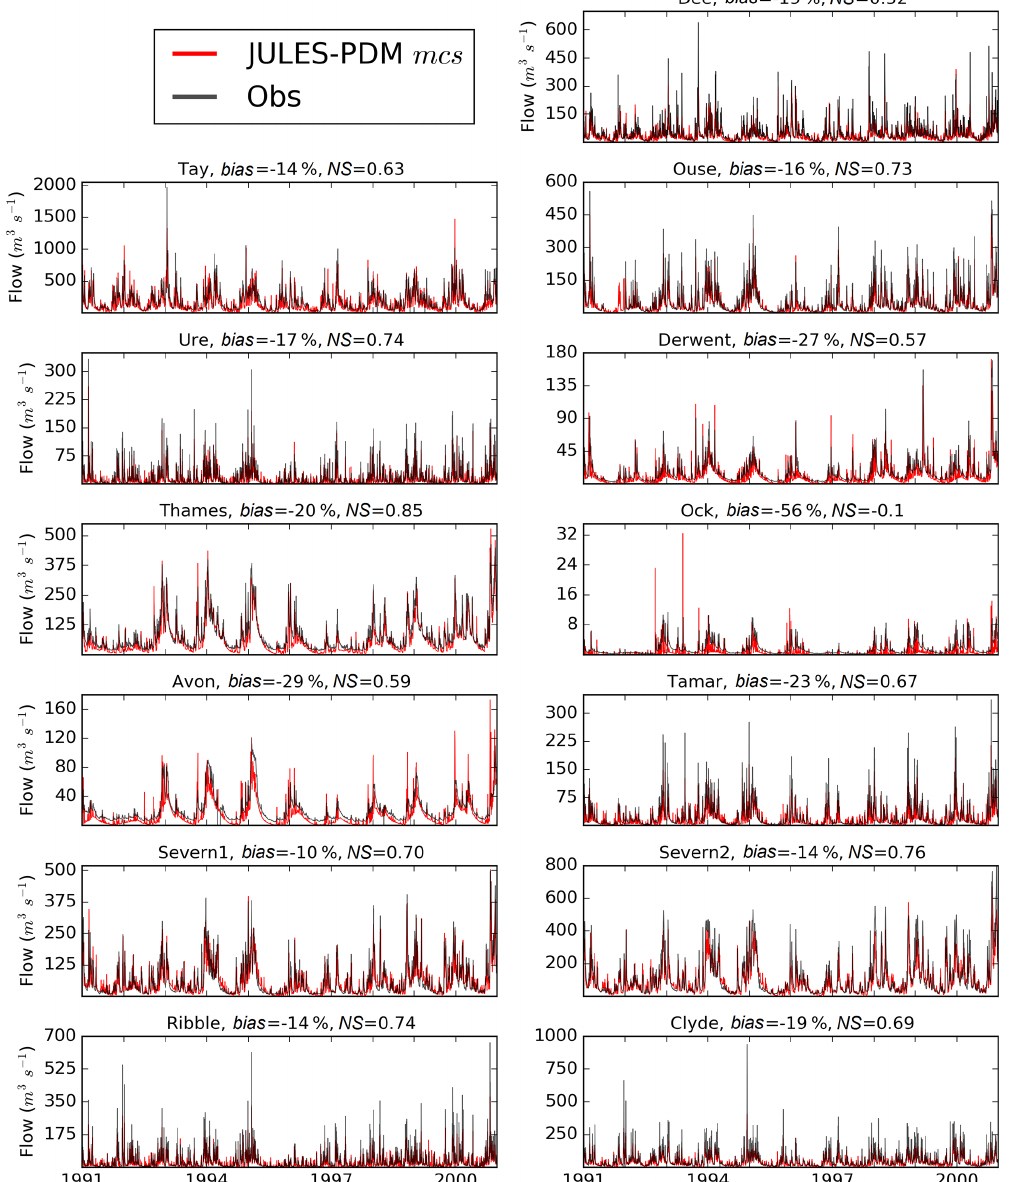
Figure 7. Daily river flow (1991–2000) for the 13 catchments studied (Fig. 1). Observations at the NRFA gauge station (Table 1) in black and simulations at the outlet grid by JULES using the criterion mcs in red. On top of each plot the name of the catchment and the performance metrics (mean bias and the NS) are